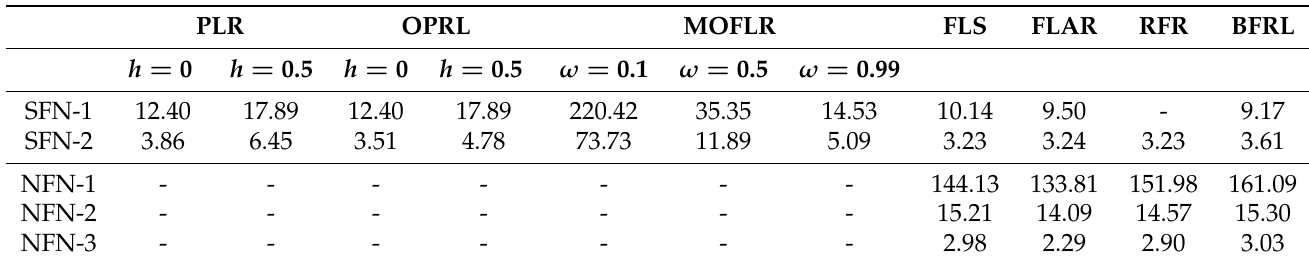
Table 1. Total errors of the possibilistic linear regression (PLR), the PLR combined with the omission approach (OPRL), the multi-objective fuzzy linear regression (MOFLR), the fuzzy least squares (FLS), the fuzzy least absolute linear regression (FLAR), the robust fuzzy regression (RFR) analysis, and the Boscovich fuzzy regression line (BFRL). Testing done on datasets with symmetric (SFN-1, n = 5 and SFN-2, n = 8) and non-symmetric fuzzy numbers (NFN-1, n = 16; NFN-2, n = 8 and NFN-3, n = 8). Settings of adjustable parameters h and ω are stated under method abbreviations.